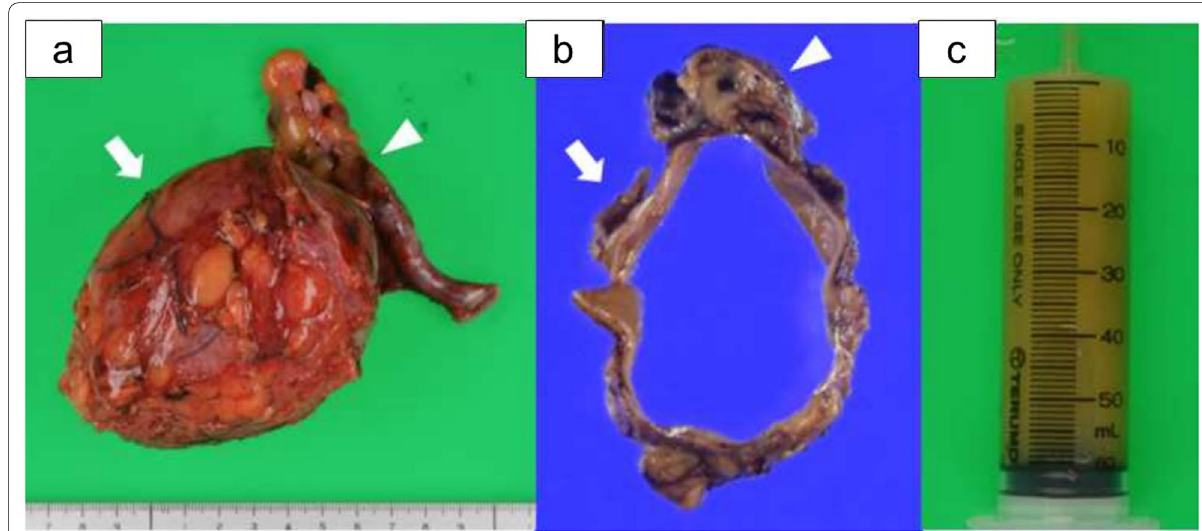
Fig. 4 Resected specimen. The resected specimens consisted of a 10 the appendix (arrow head) ( a , b ). The cystic lesion included a large amount of yellow, turbid serous fluid ( c